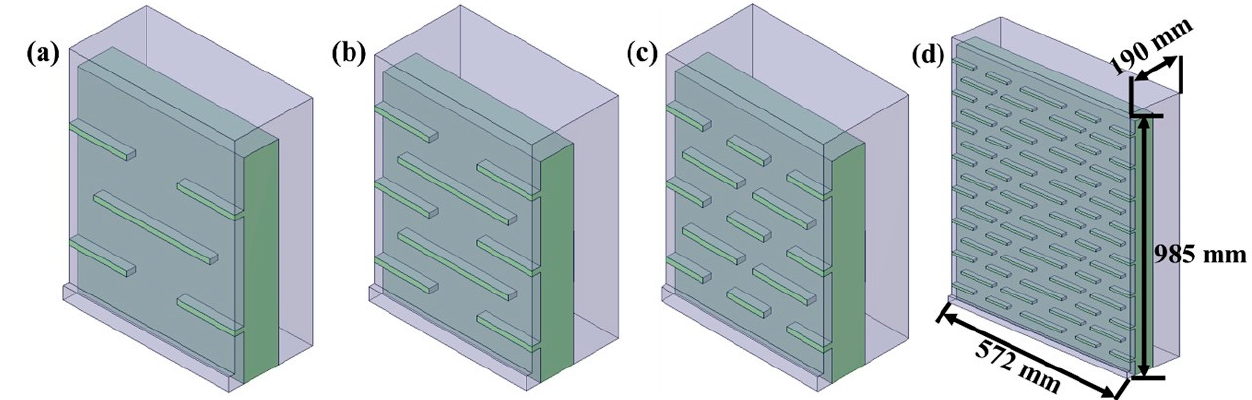
of carbon emission reduction was compared with that of conventional heating devices.